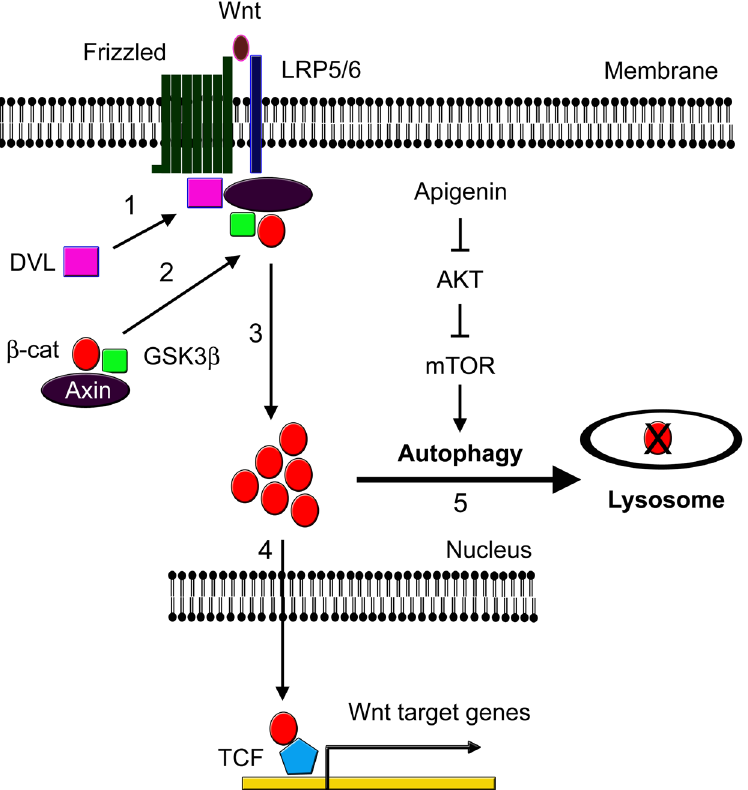
Figure 10. A model depicting the involvement of autophagy-lysosomal system in apigenin-induced degradation of β -catenin during Wnt signaling. In the presence of Wnt, Wnt ligand binds to its cognate receptor Frizzled and co-receptor LRP5/6. Dishevelled (DVL) moves from the cytoplasm to the plasma membrane and associates with Frizzled (step 1). Axin complex, including β -catenin and GSK3 β , will also be translocated to the cell membrane and bind to phosphorylated LRP5/6 through Axin (step 2). β -catenin is stabilized and accumulated in the cytoplasm (step 3), and then enters the nucleus to associate with TCF/LEF and activates the expression of Wnt-responsive genes (step 4). Apigenin treatment suppresses the AKT/mTOR signaling pathway and induces the sequestration and degradation of β -catenin inside the lysosome (step 5), contributing to down- regulation of β -catenin during Wnt